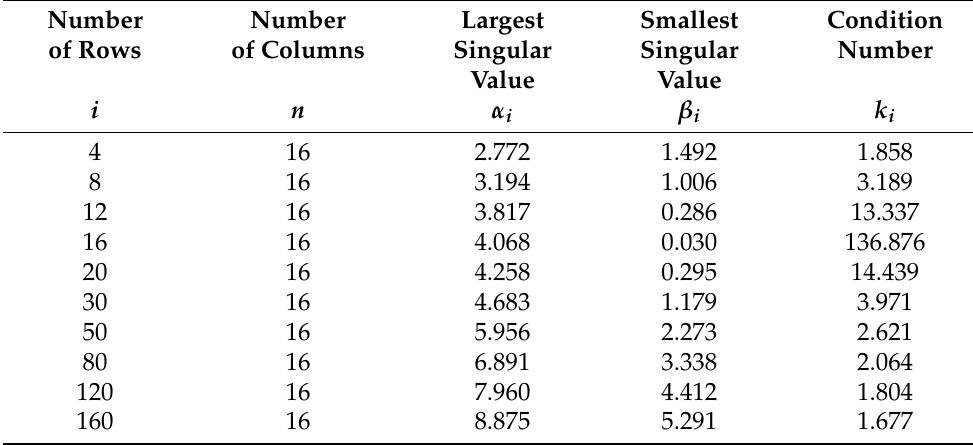
Table 4. The anomaly in small random matrix.